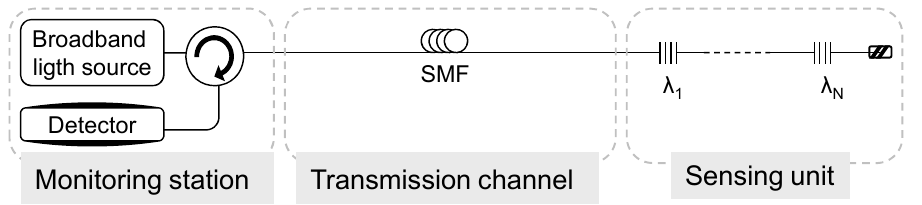
Figure 2. Conventional FBG sensor system.